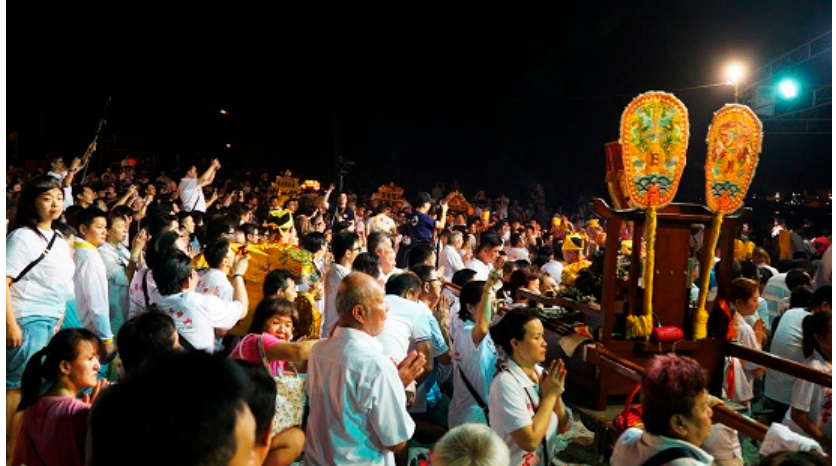
Figure 7. Devotees kneel in obeisance to the Nine Emperor Gods.